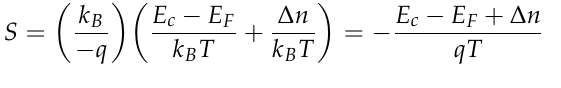
and 𝑇 are the temperatures of the hot and cold (cid:3035) (cid:3030)